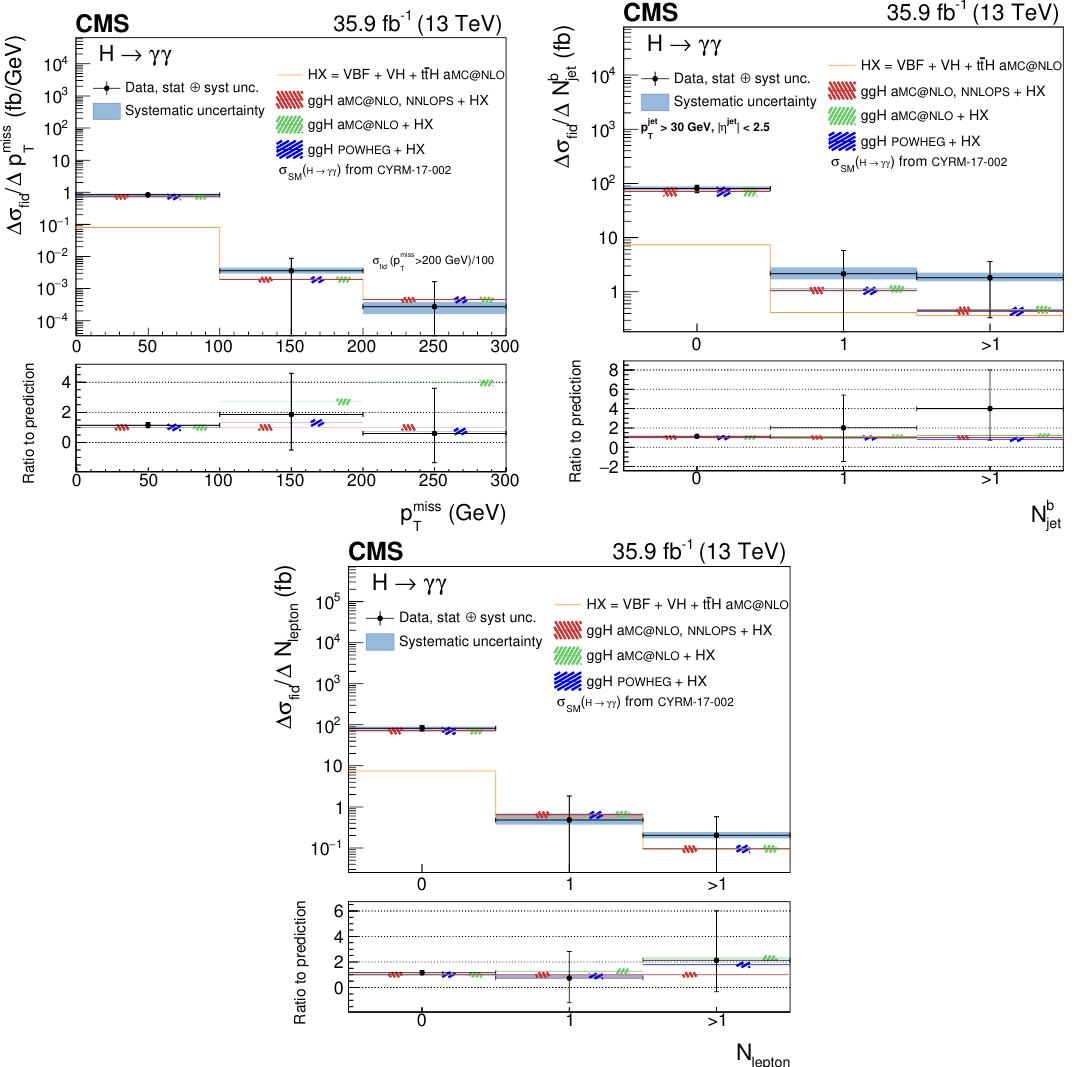
Figure 10 . Measurement of the di(cid:11)erential cross section (black points) as functions of p miss and N lepton . The error bars indicate 1 standard deviation uncertainty. The systematic component of the uncertainty is shown by the blue band. The measurements are compared to di(cid:11)erent simu- lation programs (histograms) with their uncertainties (hatched areas), all normalized to the same theoretical predictions from ref. [13]. When the last bin of the distribution is an over(cid:13)ow bin, the normalization of the cross section in that bin is indicated in the